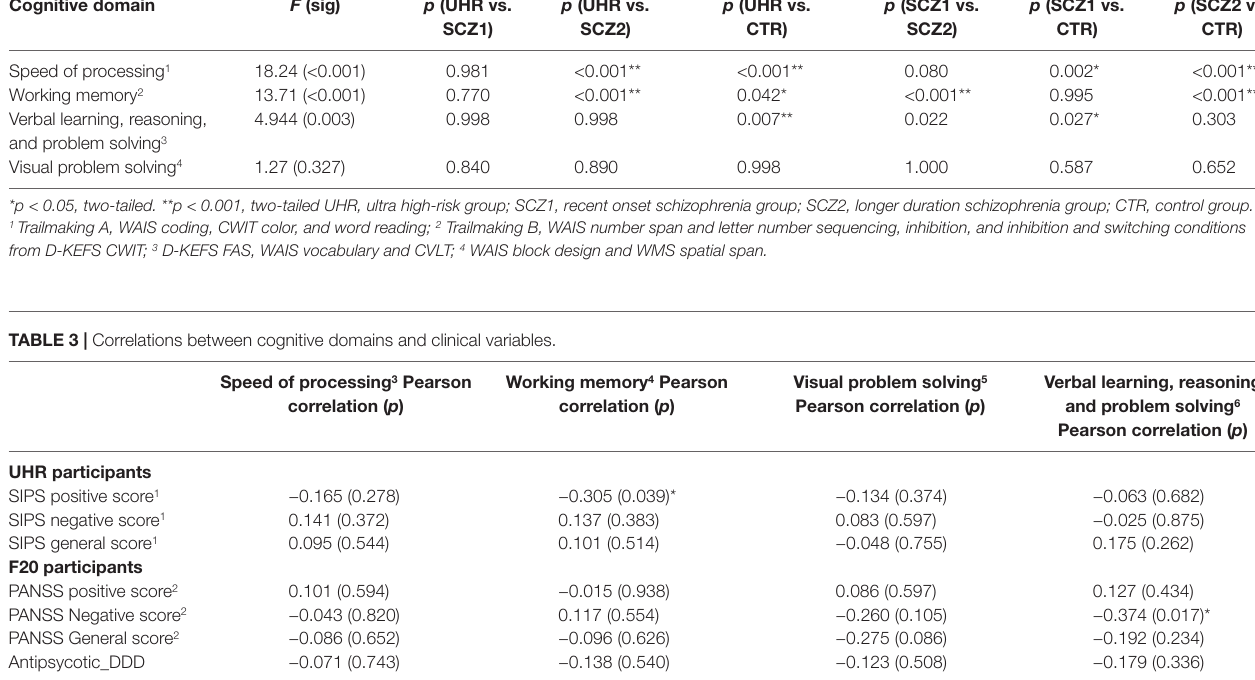
TABLE 2 | Cognitive domains z -score comparisons between UHR, schizophrenia, and control groups. Cognitive domain